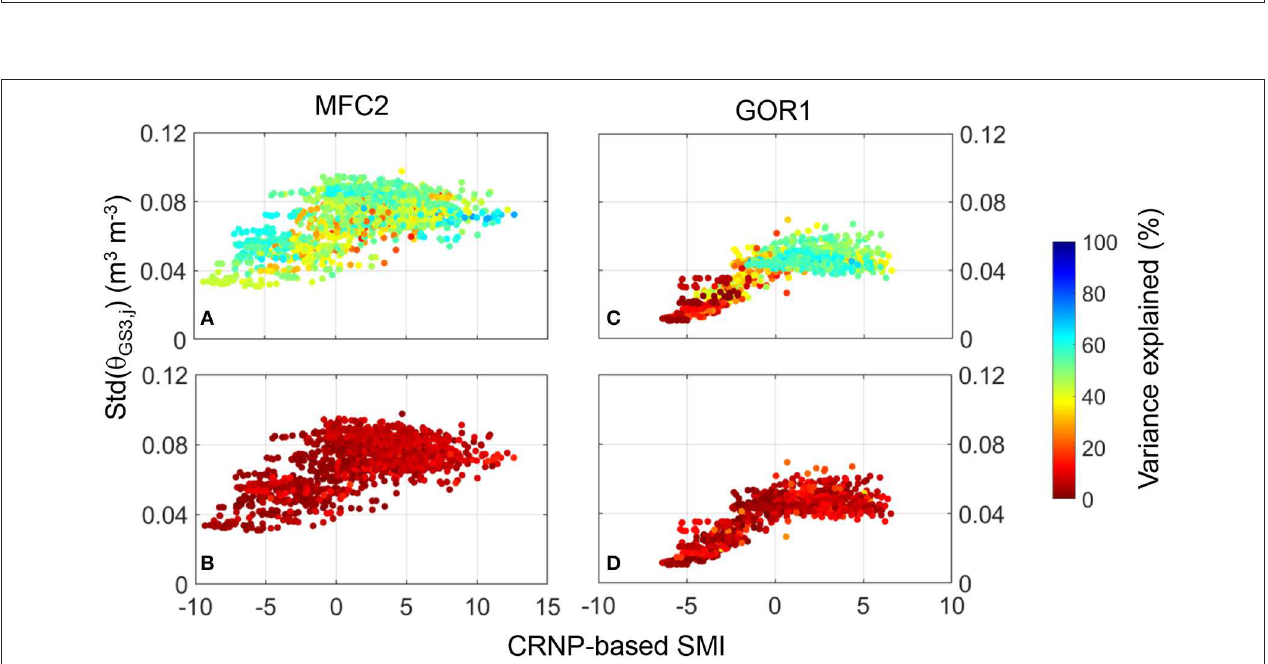
FIGURE 10 | Frequency distributions of daily values of SMI (SMI d ) calculated with SoilNet-based soil moisture at z moisture (cyan bars) at MFC2 in 2017, 2018, and 2019. Each subplot reports the bimodality coefficient (BC).